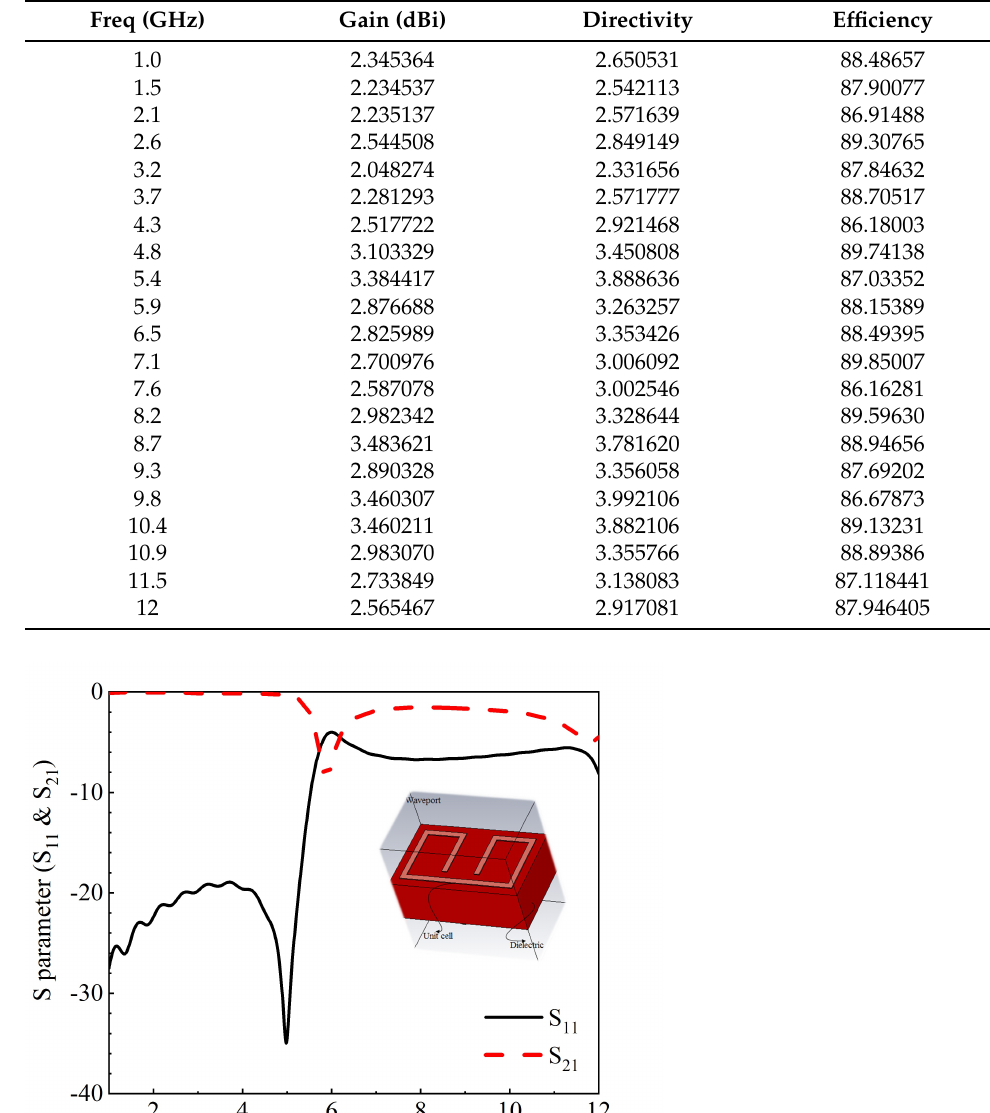
Table 2. Calculation of total efficiency of the MIMO antenna.